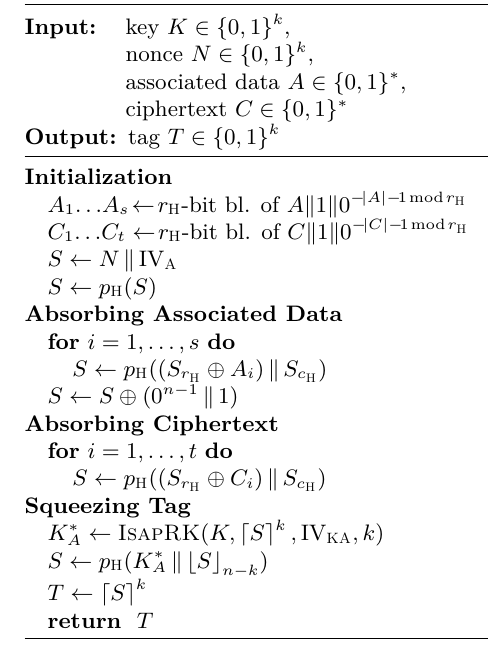
Algorithm 5 IsapMAC ( K, N, A, C